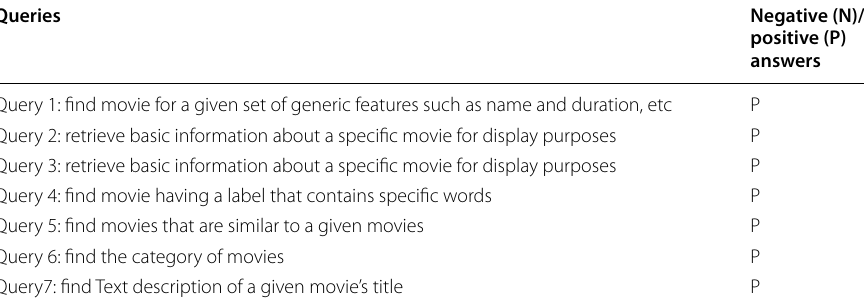
Table 11 A list of competency questions with answers